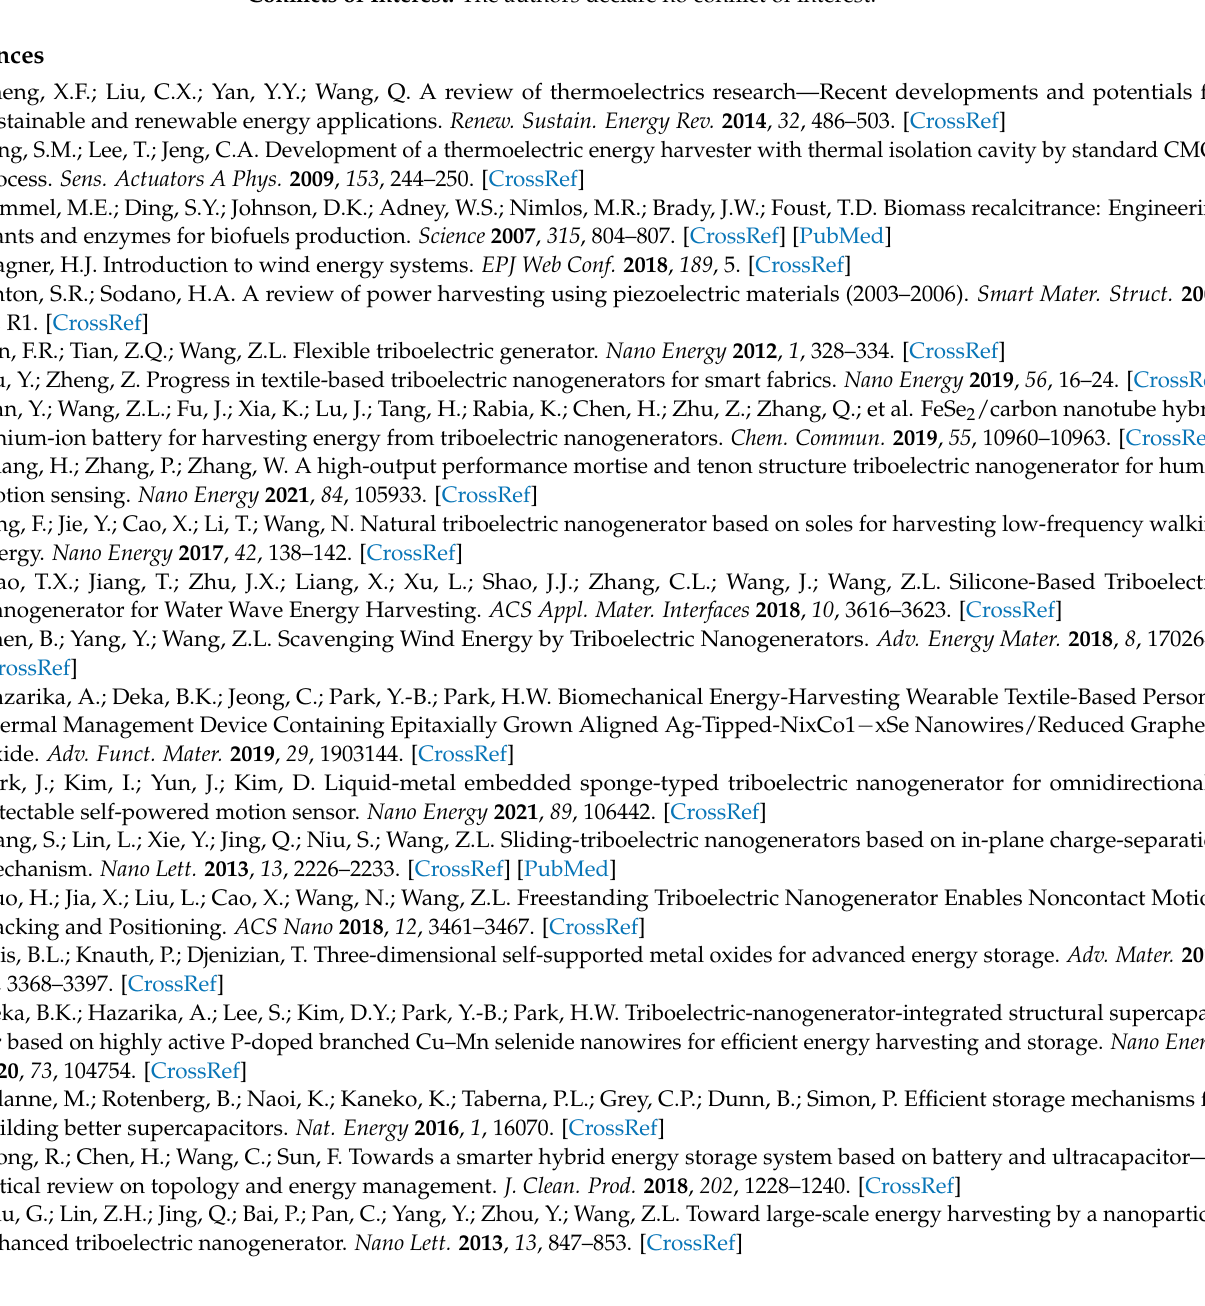
Figure S3: Electrical output of NW-TENG and W-TENG at different applied frequency; Figure S4: FE-SEM image of PANI-coated PAN membrane at different coating